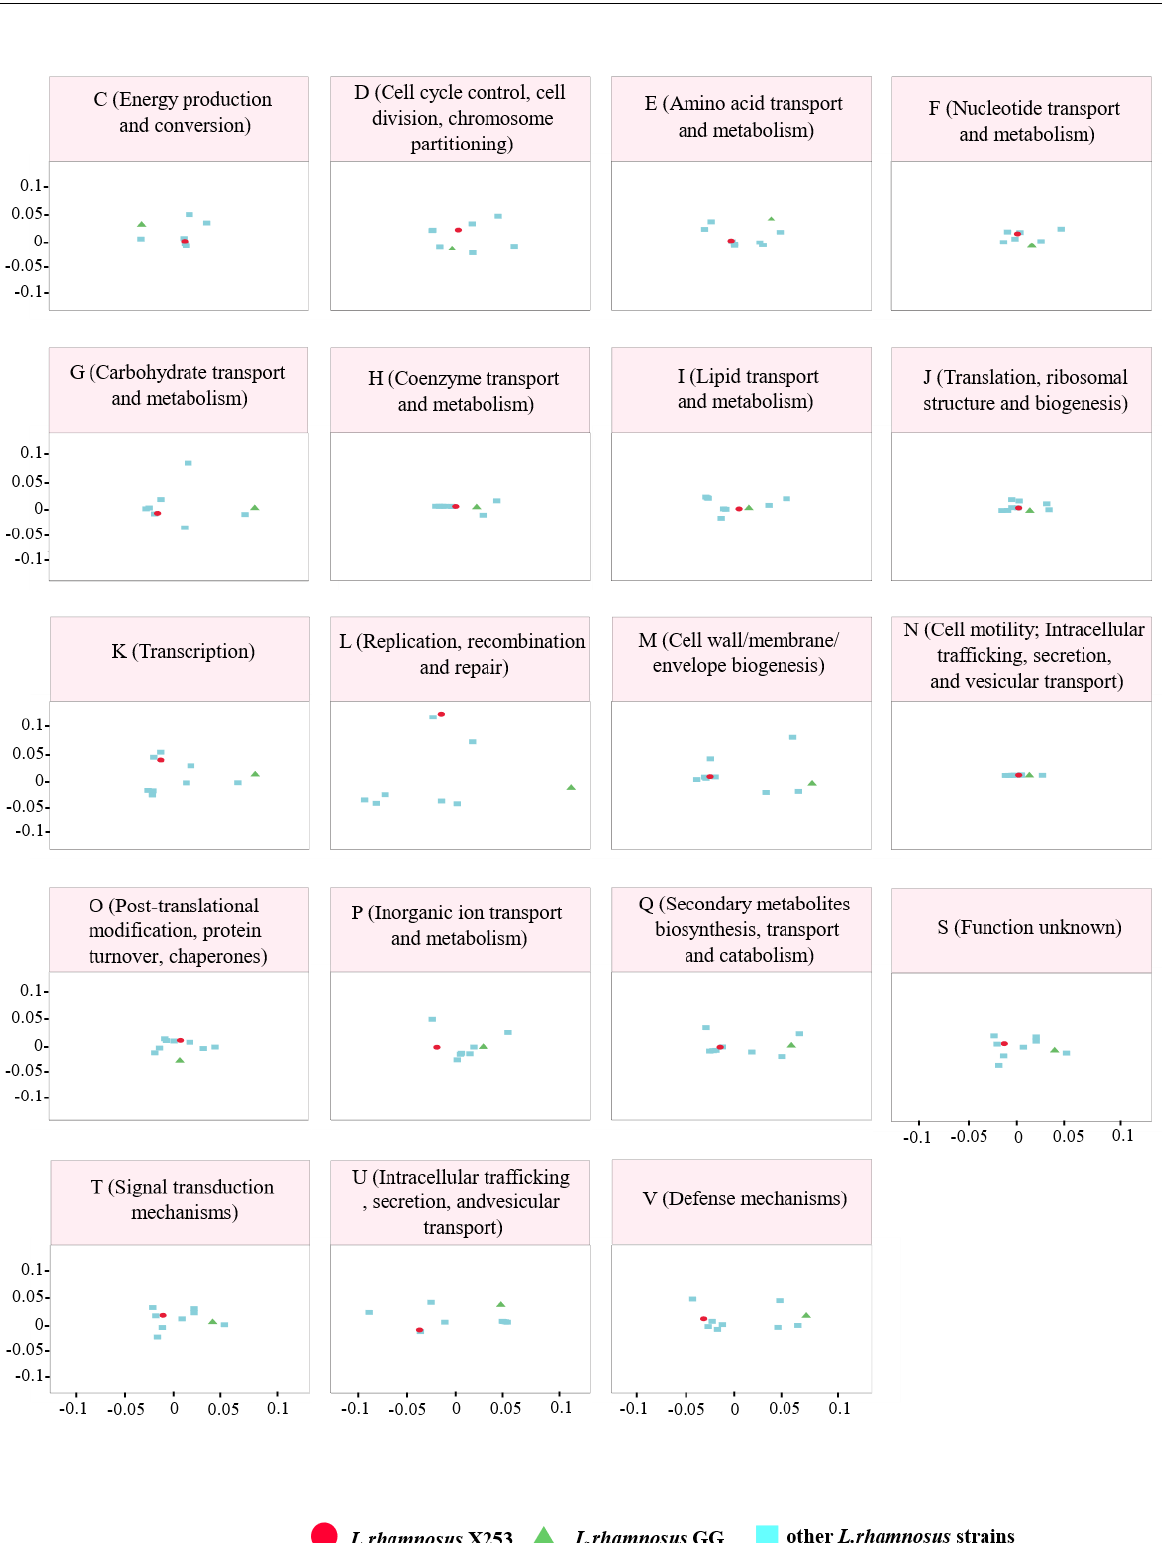
Figure 2. PCoA of the predicted functional capacity of 10 L. rhamnosus strains based on mapping of all orthogroups to the eggNOG database. Distance matrices based on orthogroup abundance profiles were calculated with the R package vegan (version 2.4.4) and visualized with ggplot2 (version 3.3.5). Each letter represents a different functional category, and L. rhamnosus X253, L. rhamnosus GG, and the other eight strains are denoted by red circles, green triangles, and blue squares, re- spectively.